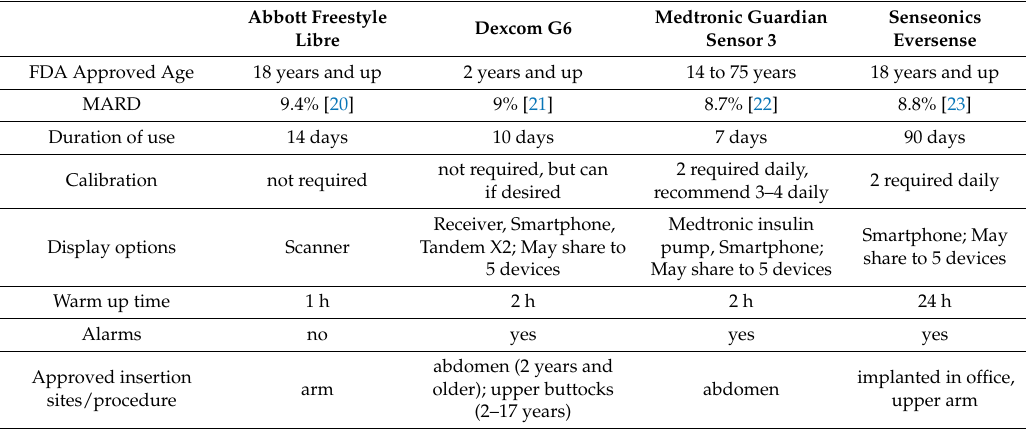
Table 1. An overview of currently available CGM